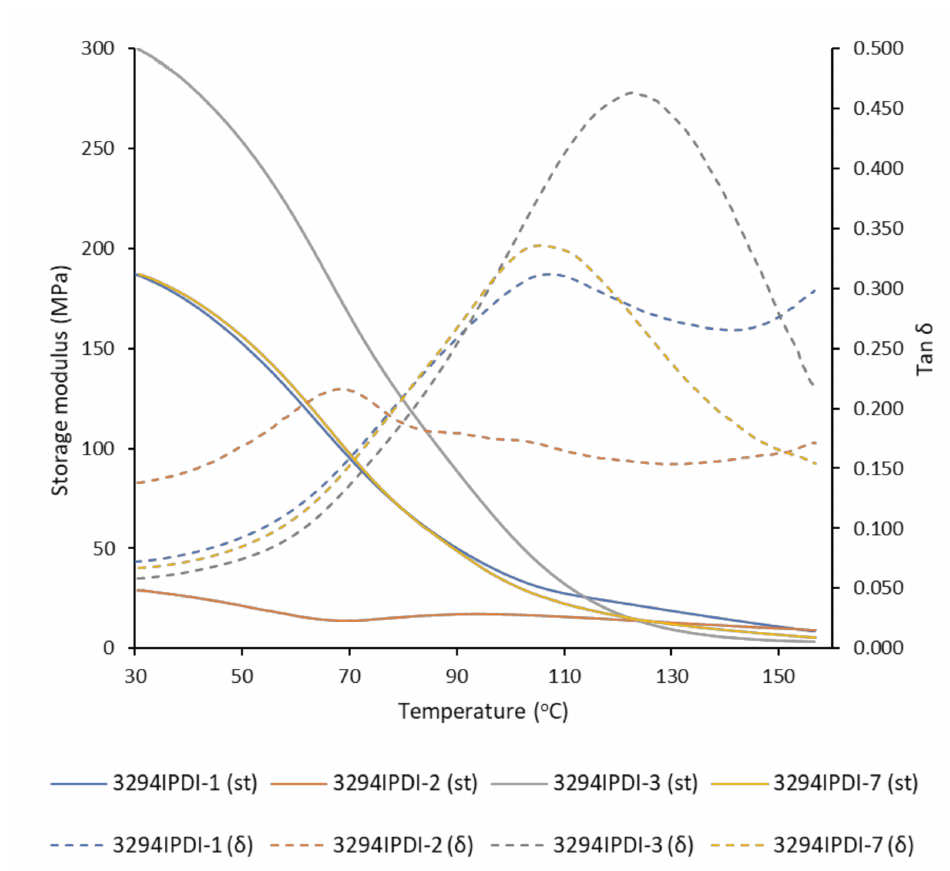
Figure 10. DMTA curves of synthesized WPUD films. Storage modulus (full lines) and tan δ (dashed